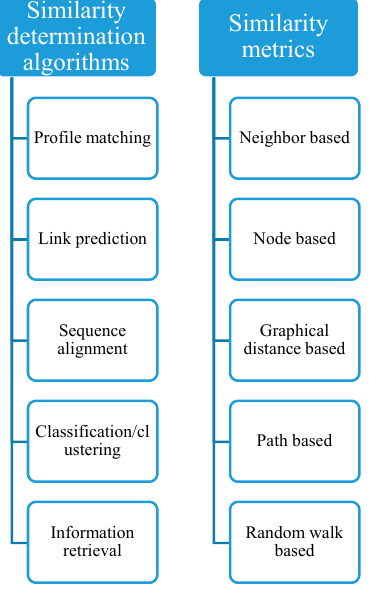
Figure 1. algorithms and kinds of similarity metrics. Figure 1. Algorithms and kinds of similarity